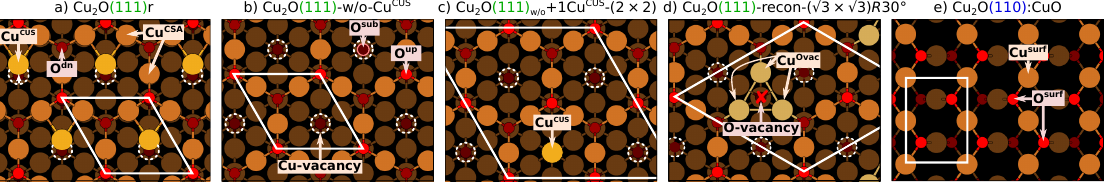
Figure 1. Top-views of considered Cu 2 O surface structures with various Cu (bigger brown balls) and O (smaller red balls) ions labeled graphically. ( a )–( d ) four different Cu 2 O(111)-type surfaces and ( e ) Cu 2 O(110)-type surface. The unit cell of each surface structure is indicated with a white parallelogram. For a more detailed graphical representation of these models, see Figures 1 and 2 in Part I